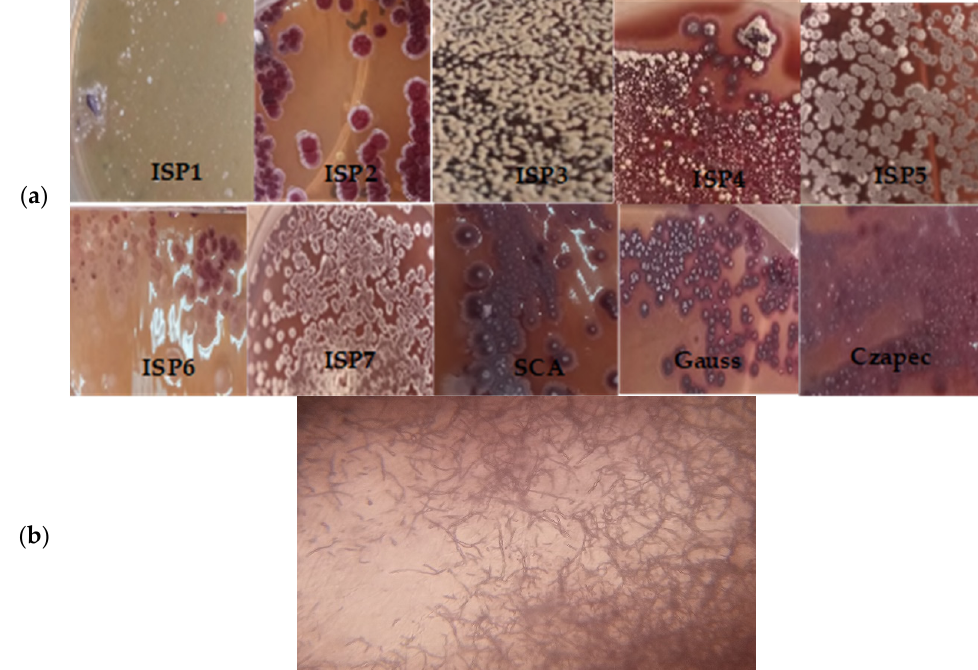
Figure 1. ( a ) Morphological characterization of CMB47 colony observations made on different ISP and some culture media. ( b ) Microscopic observation of the mycelial network of branched hyphae of